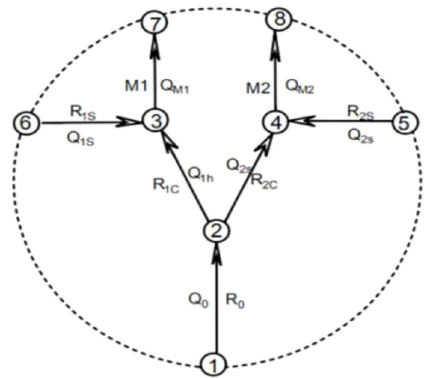
Fig. 4. Equivalent model of fan switchover